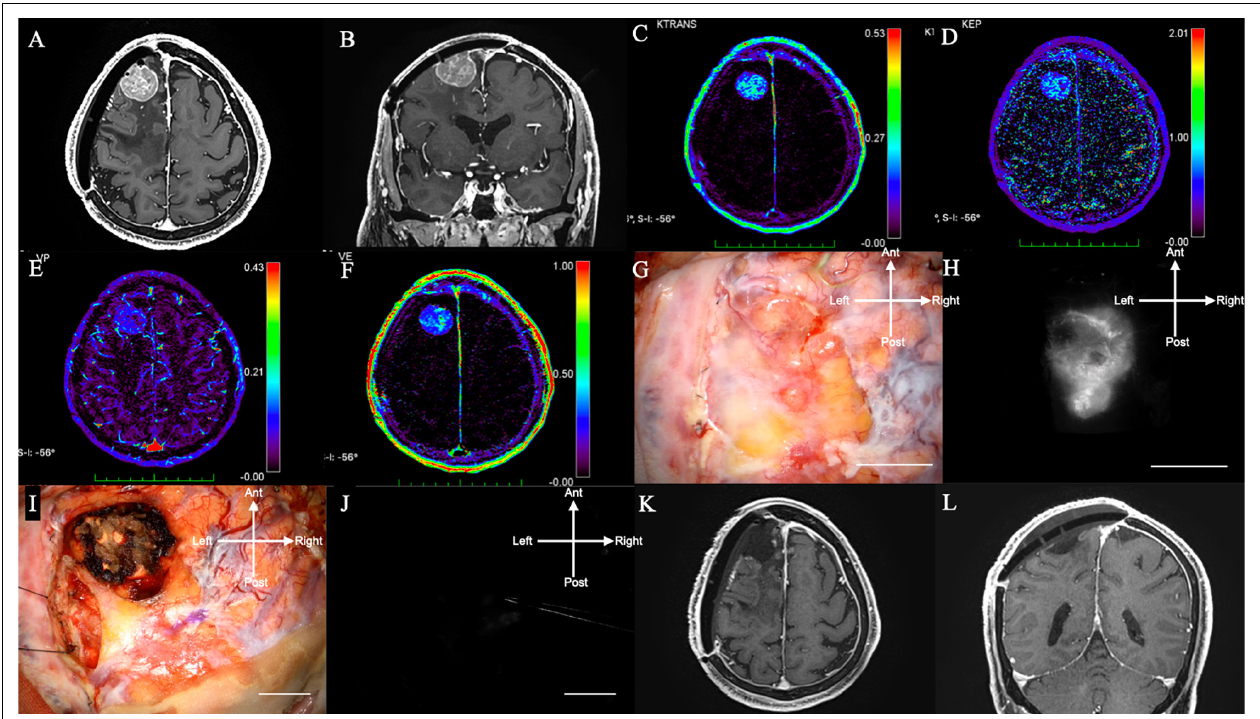
FIGURE 2 | (Case 5). Convexity meningioma in the right frontal lobe displaying NIR fluorescence using a KINEVO microscope. (A) Axial and (B) sagittal Gd-enhanced T1-weighted pre-operative MRI showing the ring enhanced lesion in the left frontal lobe. (C) K trans , (D) K ep , (E) V e , and (F) V p on additional MRI. (G) Bright light image of the dura mater. (H) NIR fluorescence of the dura mater showing NIR fluorescence localized to the tumor. (I) Bright light image. (J) No NIR fluorescence after resection. (K) Axial and (L) sagittal Gd-enhanced T1-weighted postoperative MRI showing no residual lesion. NIR, near-infrared; Gd, gadolinium; MRI, magnetic resonance imaging; K trans , volume transfer constant; K ep , rate constant; V e , volume of the extravascular extracellular space; V p , vascular plasma volume.